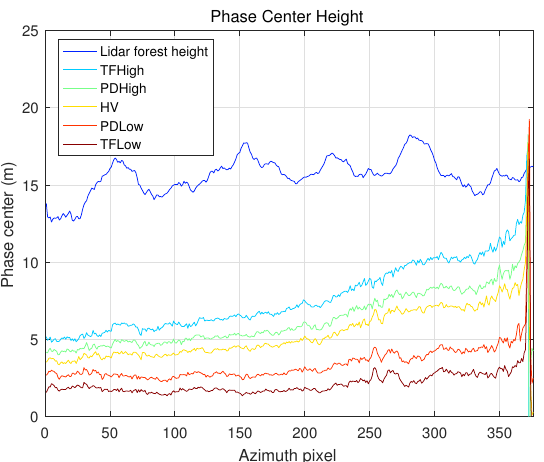
Figure 11. The phase center height for different polarimetric channels. The phase center height has been processed by averaging along the azimuth